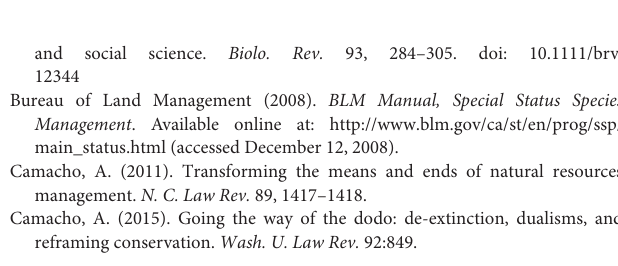
Supplementary Table 1 | Regulatory classification for Harwood’s woolly star under climate-driven migration